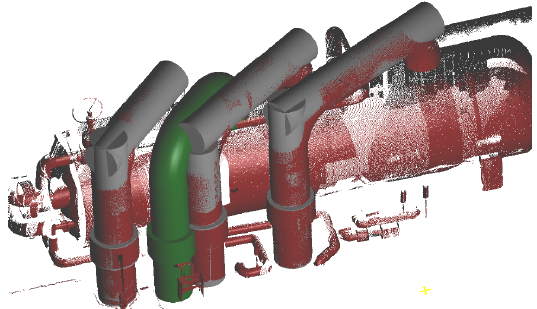
Figure 3: Reconstruction from a partial 3D model. As it searches for a model that is similar to the a priori (green), our approach only retrieves the appropriated parts (grey) in the point cloud (red). We use the same parameters as for the scene in Figure